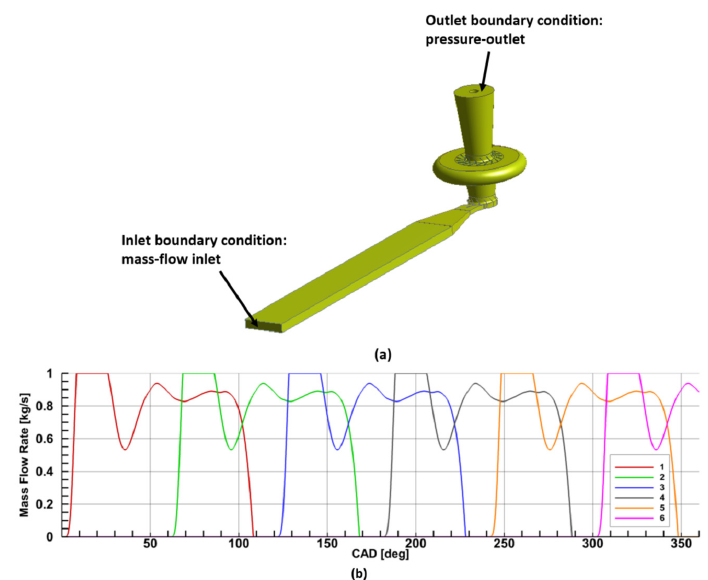
Figure 4. ( a ) The inlet mas-flow rate and pressure-outlet boundary conditions, ( b ) boundary mass flow rate changes at the inlet to the exhaust pipes